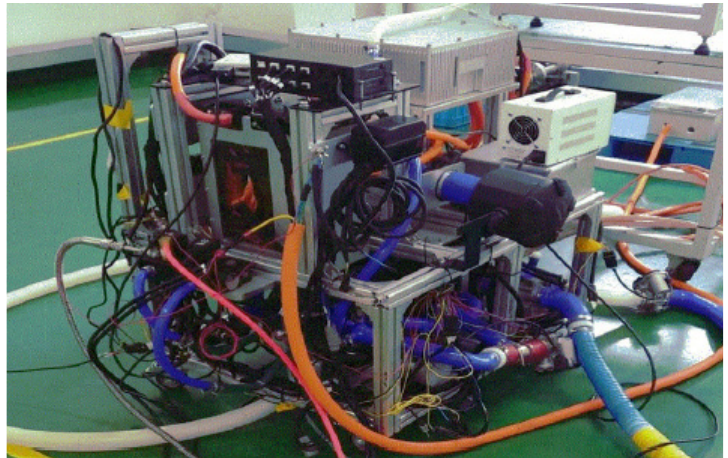
Figure 3. Equipment used in the analysis of the fuel cell’s health state.